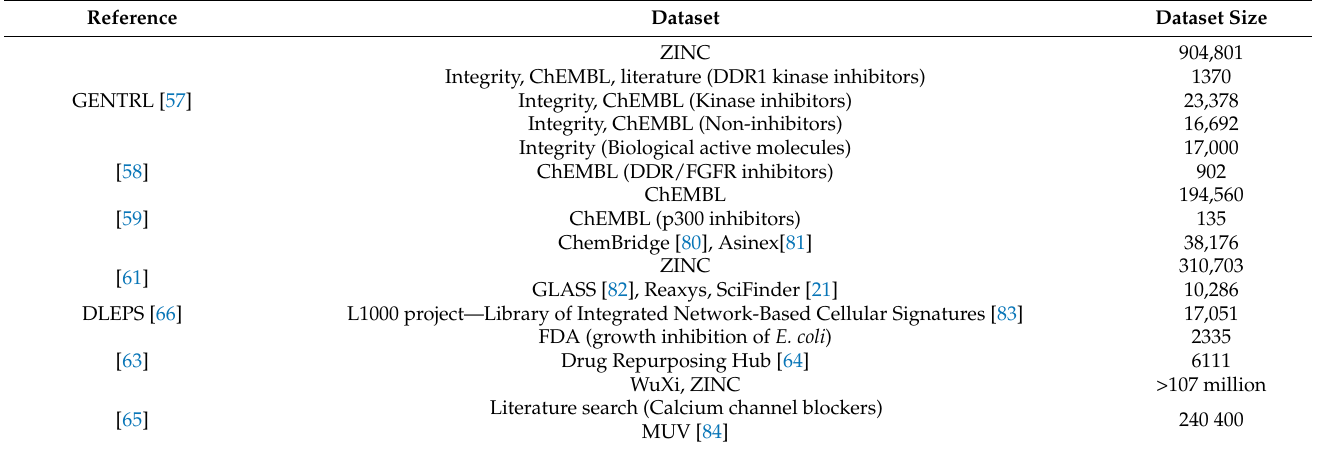
Table 1. A list of data used for training models for de novo molecular design and molecular property prediction. The dataset size is presented in number of